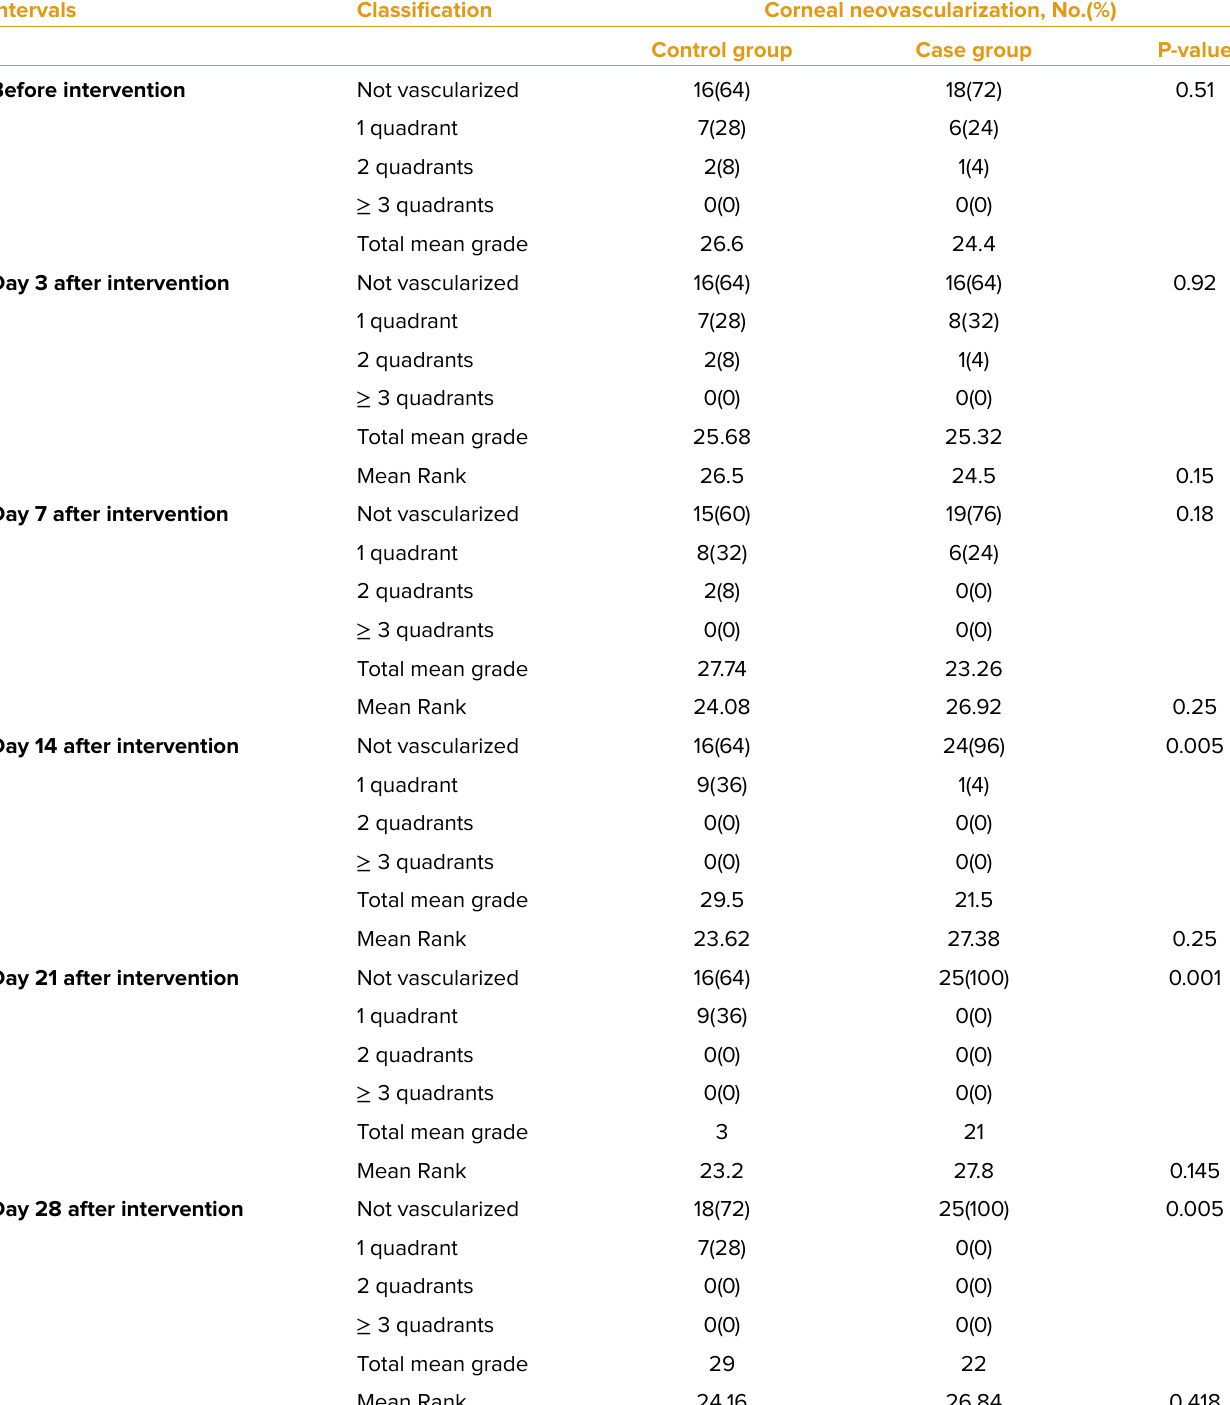
Table 3. Comparison of the corneal vascularization at the baseline, 3, 7, 14, 21, and 28 days after the intervention between the